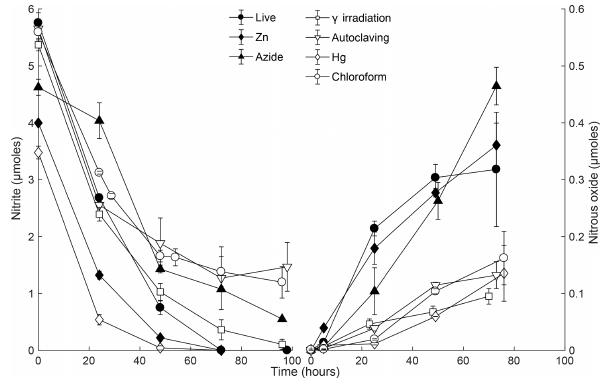
Figure 5. NO − consumption (left) and N 2 O production (right) for 2 different sterilant treatments in soil slurry incubations of Quisto- cocha peat soil. Both N species were simultaneously measured in all treatments. The product yield represents N 2 O-N as molar fraction of NO − -N. Note the difference in the left and right y axis scales. Er- 2 ror bars are 1 SD ( n = 3). Treatments are as in the legend of Fig.